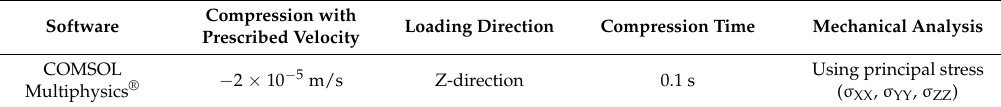
Table 1. Analytical methods and conditions used in computer numerical